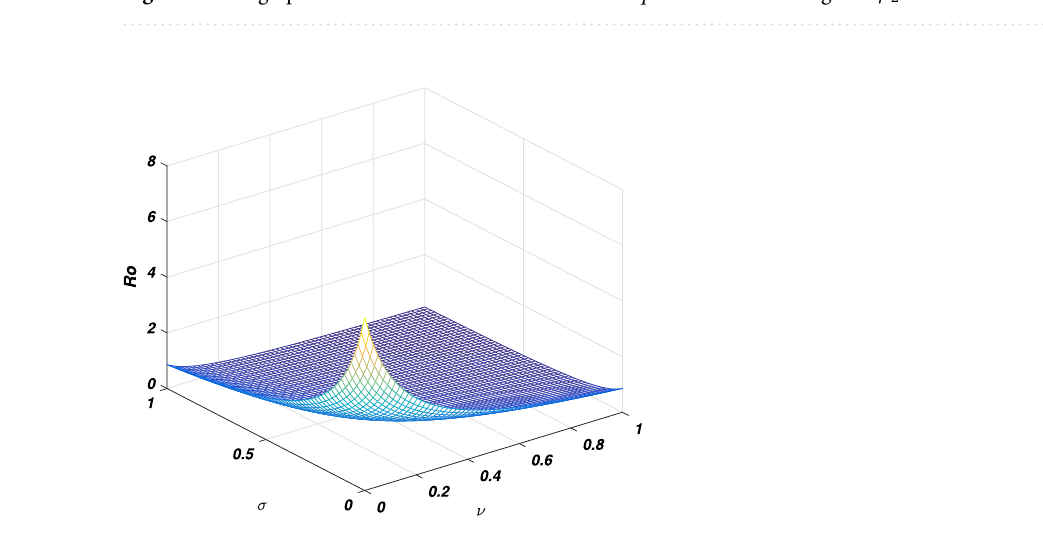
Figure 5. The graph visualizes the variation of the basic reproductive number against σ and ν